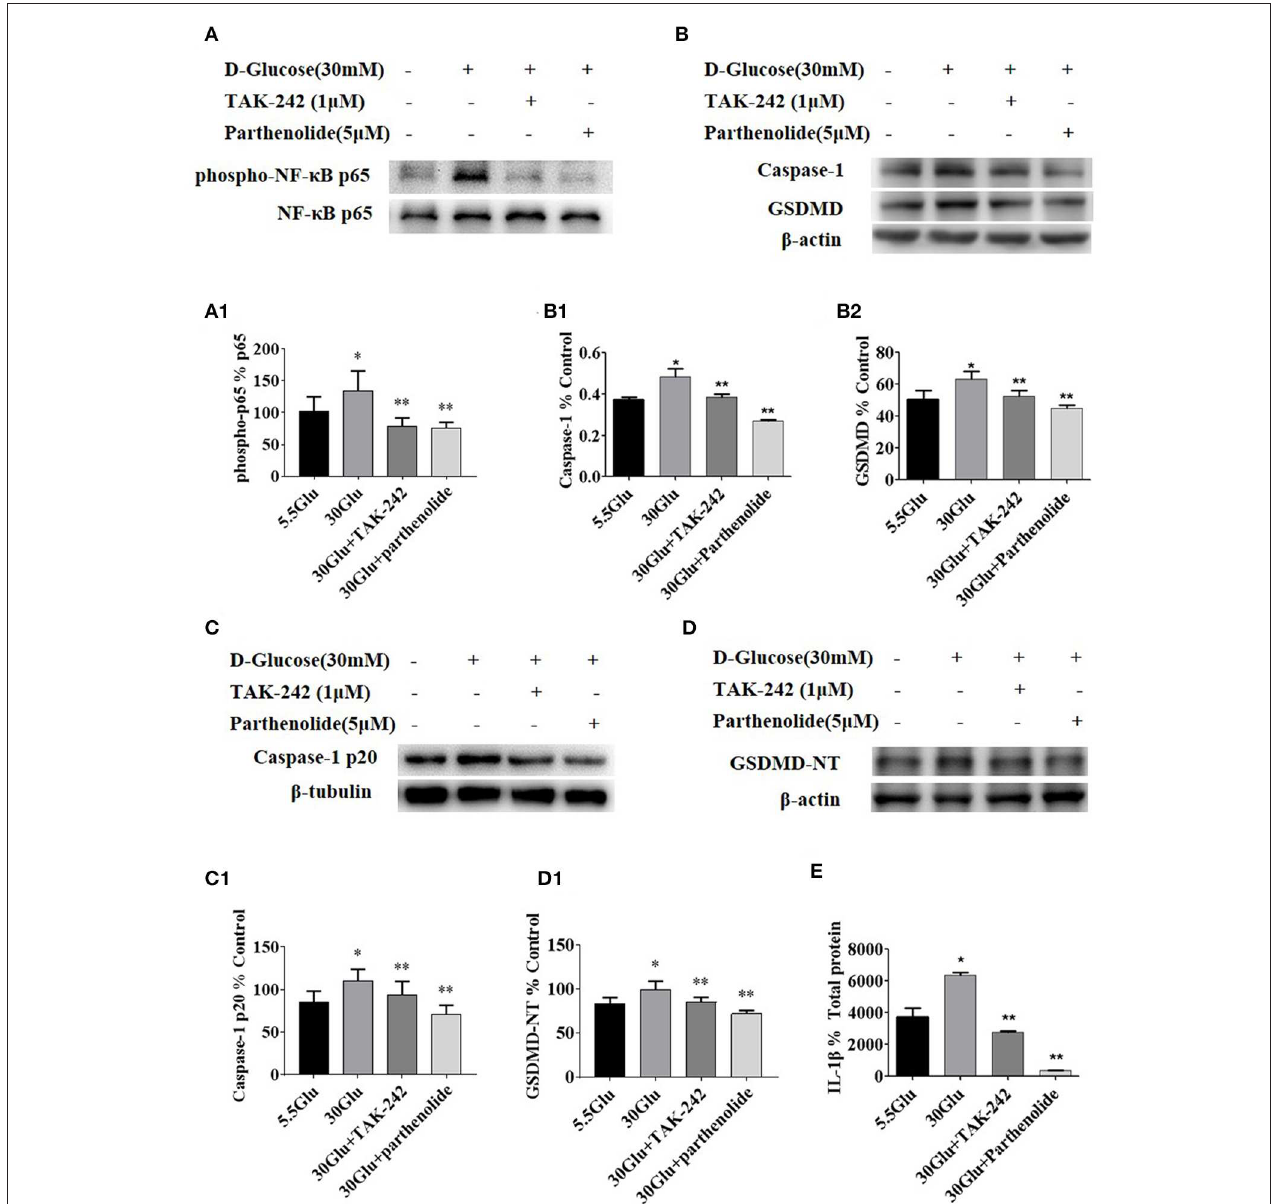
FIGURE 4 | Inhibition of TLR4/NF- κ B signaling decreased the expression of caspase-1 and GSDMD in HK-2 cells under HG condition. (A) HK-2 cells were treated with TLR4 inhibitor (TAK242, 1 µ M) for 2h prior to HG (30mM) treatment and with NF- κ B blocker (parthenolide, 5 µ M) and HG (30mM) for 2h, phospho-NF- κ B p65 increased in 30mM HG for 2h compared to the control, while TAK-242 and parthenolide alleviated HG-induced NF- κ B p65 phosphorylation. (B–D) HK-2 cells were treated with TLR4 inhibitor (TAK-242, 1 µ M) for 2h prior to HG (30mM) treatment for 24h or with NF- κ B blocker (parthenolide, 5 µ M) and HG (30mM) for 24h, and samples were collected for Western blot analysis to detect caspase-1 (B1), GSDMD(B2), caspase-1 p20 (C1) and GSDMD-NT(D1) expressions. (E) IL-1 β level in supernatant of HK-2 cells measured by ELISA was increased in 30mM glucose group and reversed both in 30GLU + TAK242 and 30GLU + parthenolide groups. Each assay was representative of three independent experiments. Data were expressed as means ± SEM. (* P < 0.05 vs. control group; ** P < 0.05 vs. 30Glu